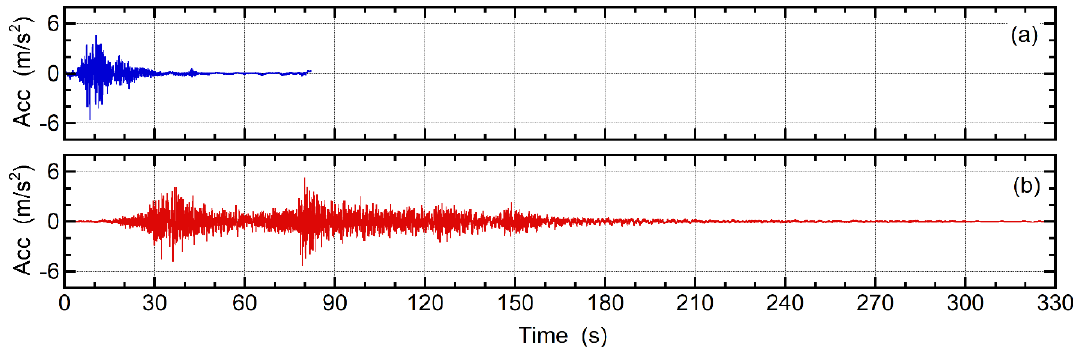
Figure 6. Example wave of the generated artificial ground motion: ( a ) Art-S00 and ( b ) Art-L00.